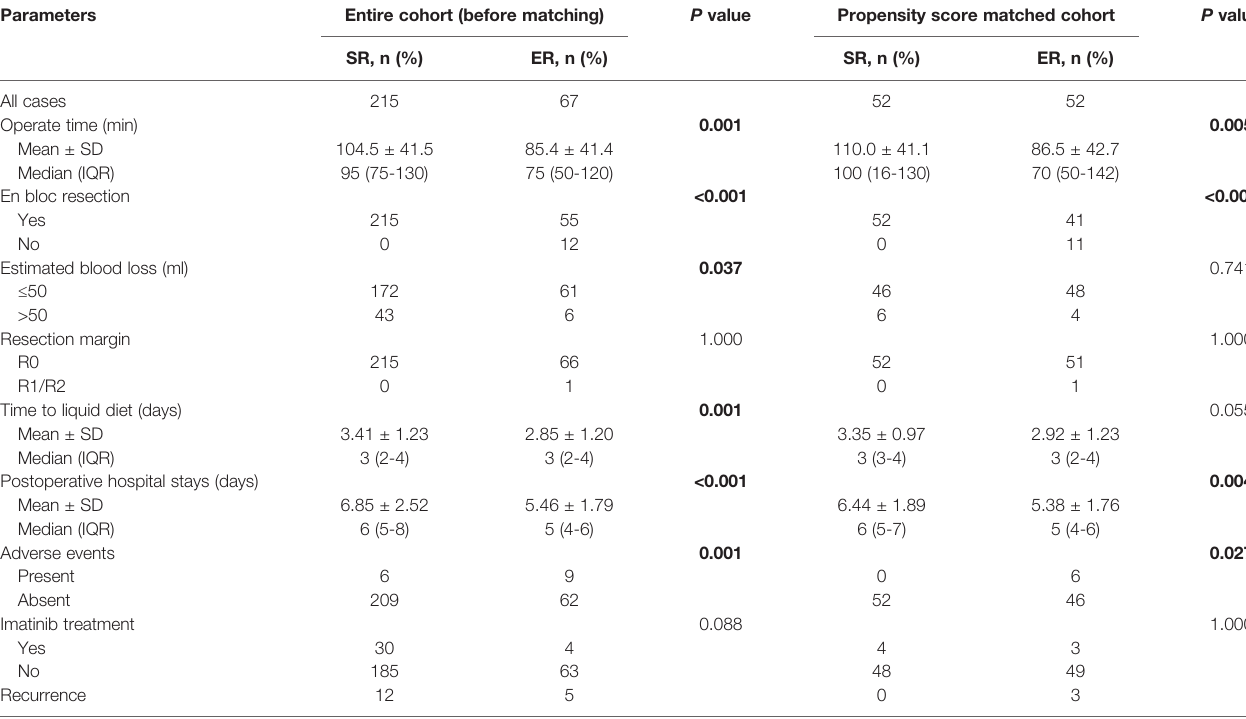
TABLE 4 | Perioperative characteristics and long-term outcomes of SR and ER group in the entire cohort and after propensity score matching.